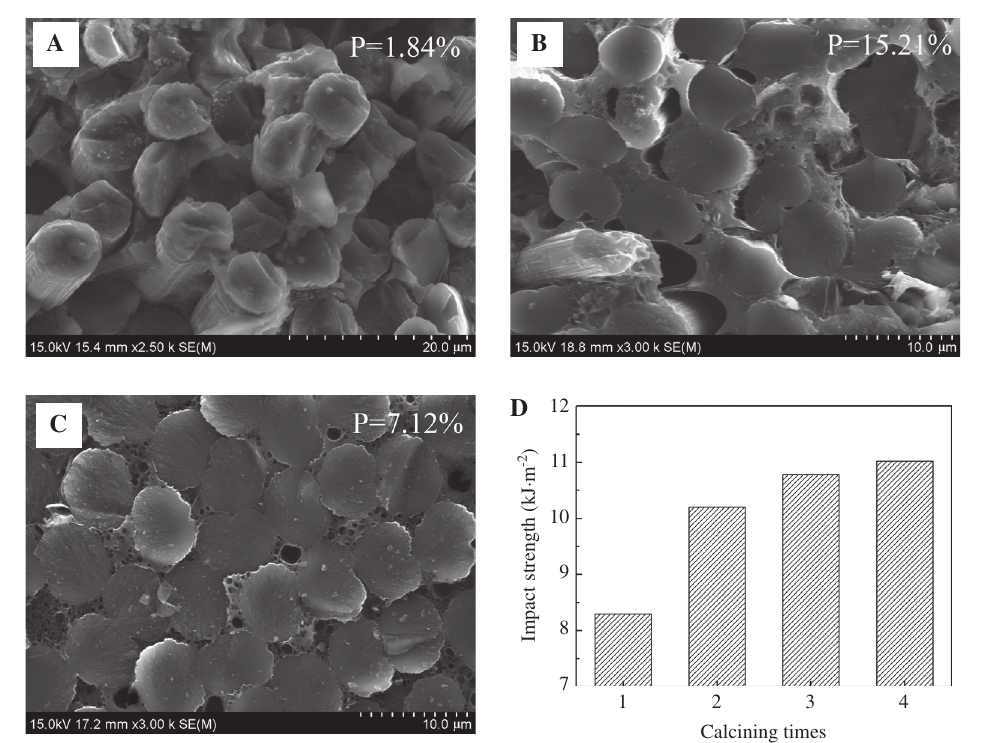
Figure 12 SEM photo of specimens’ surface topography before and after impregnation. (A) Untreated; (B) after one time carbonization; (C) after four times IC; (D) impact